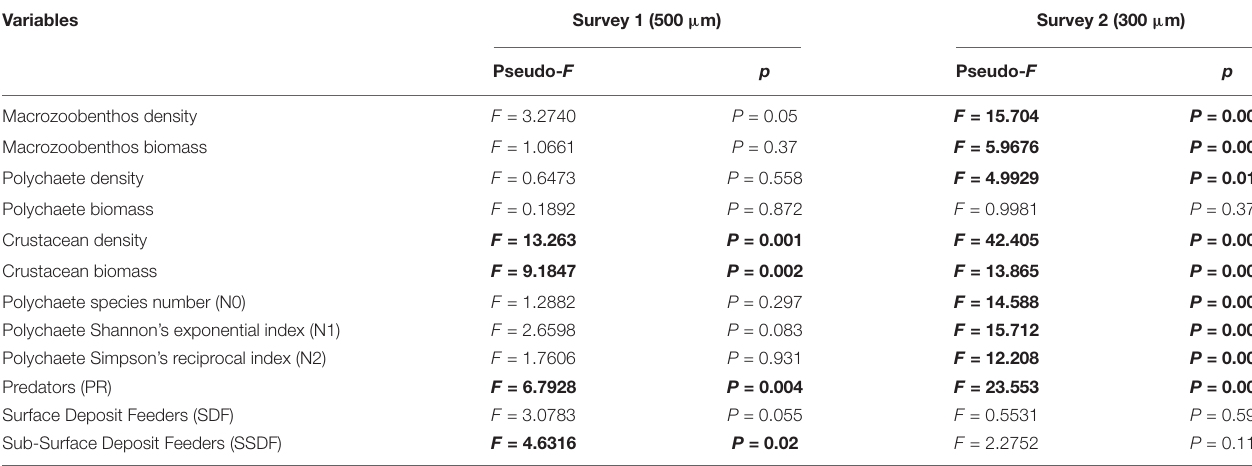
TABLE 3 | Results of PERMANOVA test for bathymetric variations in macrozoobenthic standing stock, polychaete diversity indices and feeding guilds composition (values in bold indicate statistical significance with p <